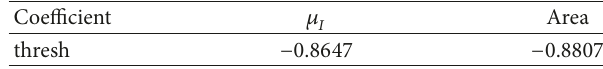
Table 1: Percentage of radium was selected for different image processing.